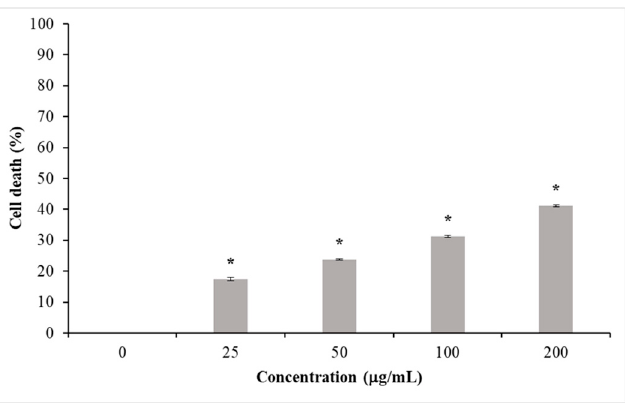
Figure 2. The cytotoxic effect of the ethanolic extract of C. incana in HepG2 liver cells using an MTT assay. Data were presented as the mean ± SD (N = 3). * p < 0.05 vs. untreated cells (control) (ANOVA, Tukey’s post hoc test).